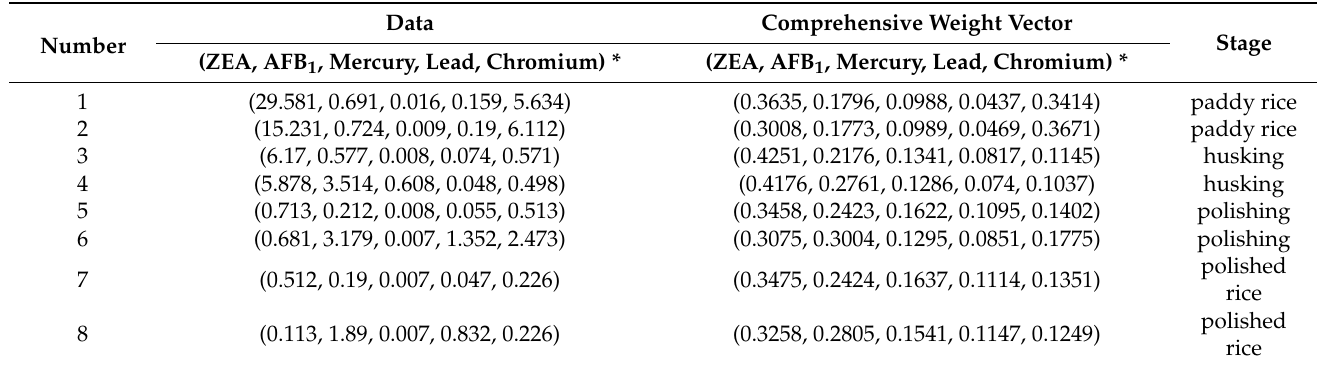
Table 4. Part of the data and comprehensive weight